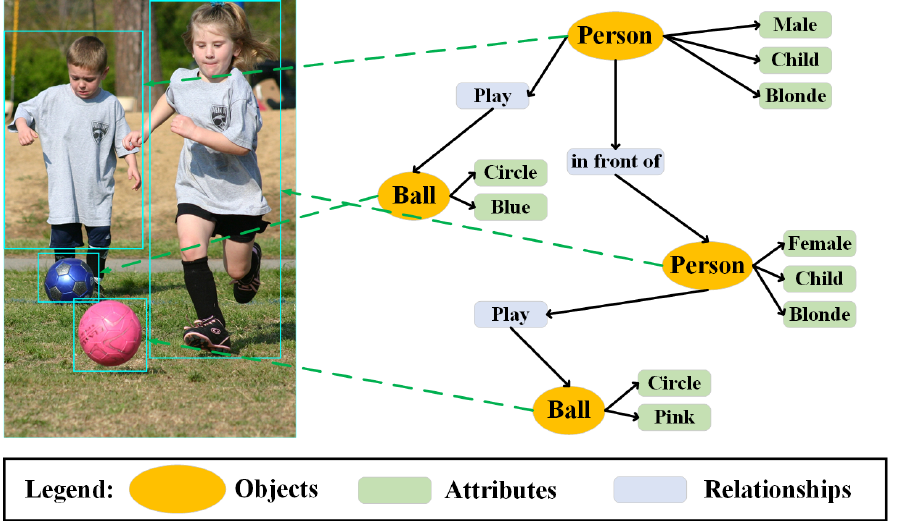
Figure 6. The scene graph, depicting the objects, their low-level attributes and their relationships.